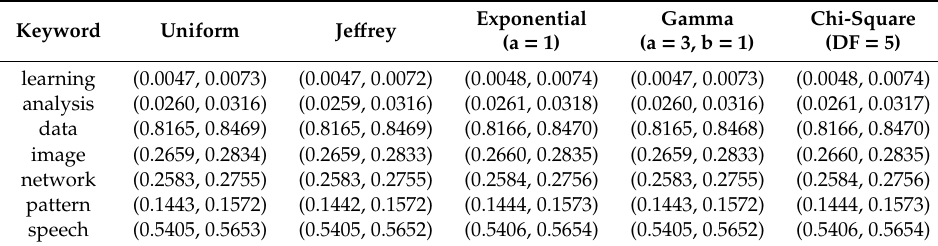
Table 3. Bayesian intervals for eight representative keywords.